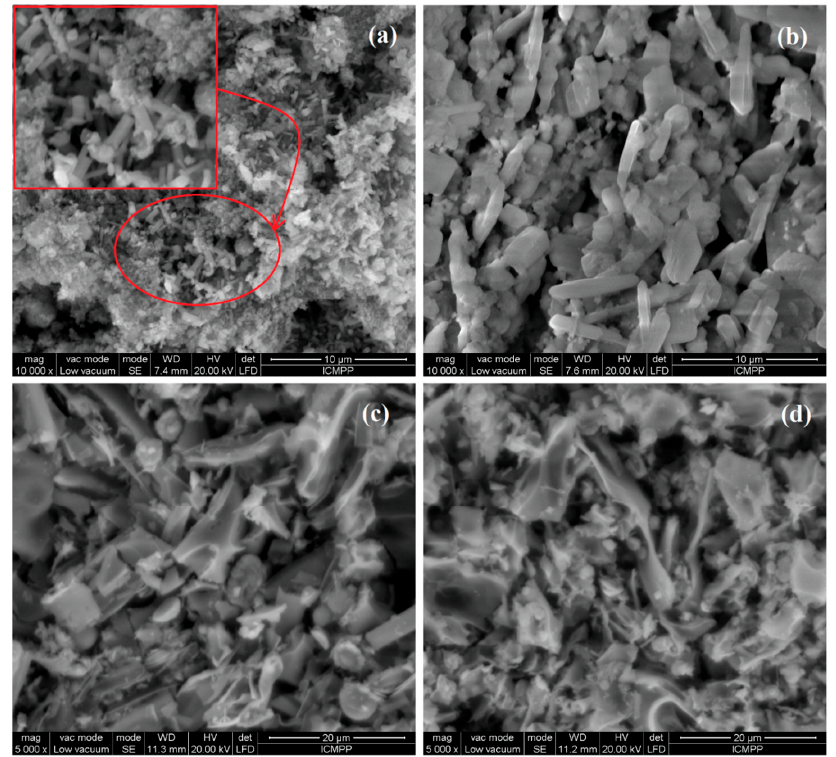
Figure 1. Scanning electron microscope (SEM) images of the ZnO (S1) ( a ), MoO 3 (S2) ( b ), ZnO:MoO 3 (S4) ( c ) and ZnO:MoO 3 (S5) ( d ) nanostructures.